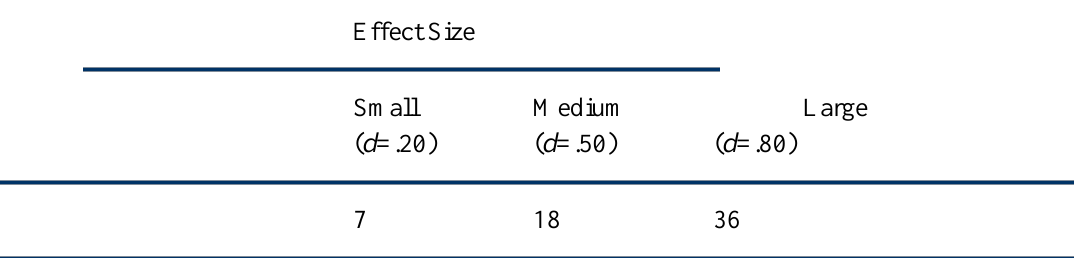
Approximate Sample Size Needed for 80% Power (α =